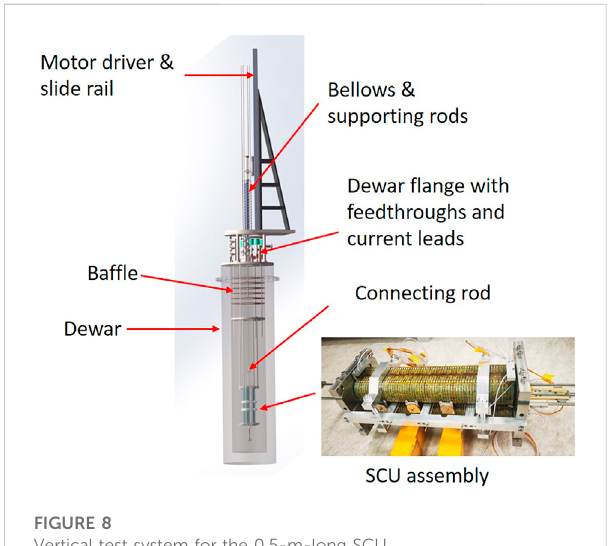
FIGURE 8 Vertical test system for the 0.5-m-long SCU.